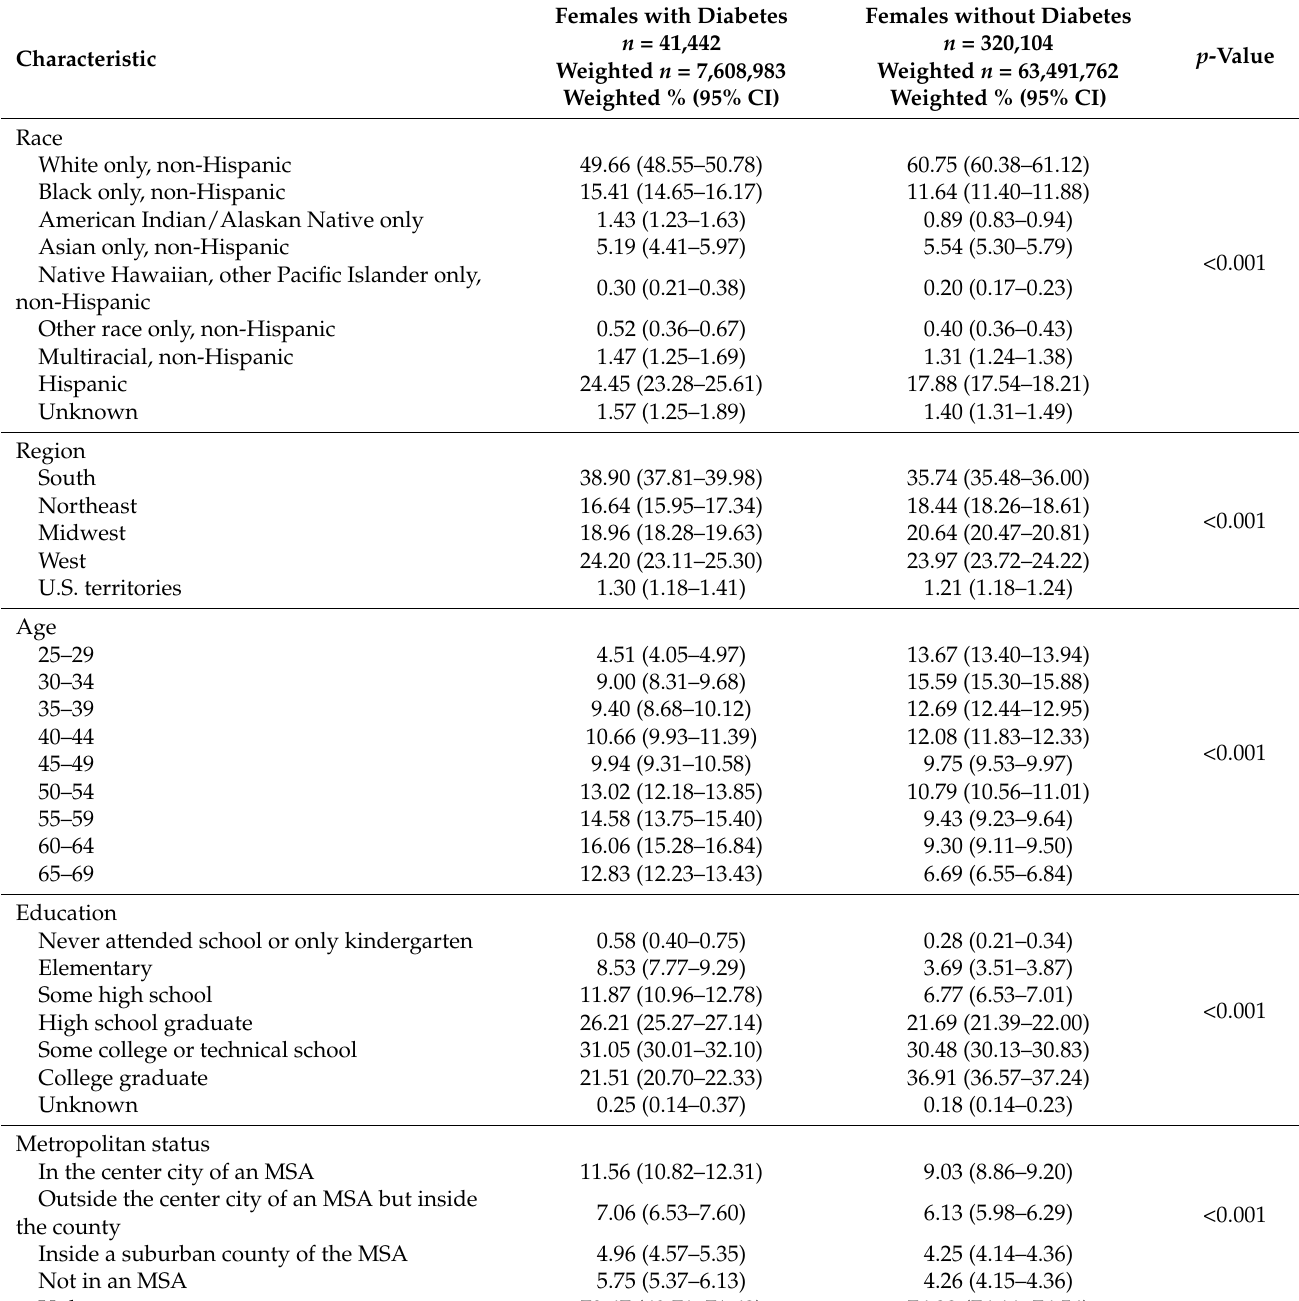
Table 1. Characteristics of Female Study Population, Stratified by Diabetes Diagnosis a . Characteristic